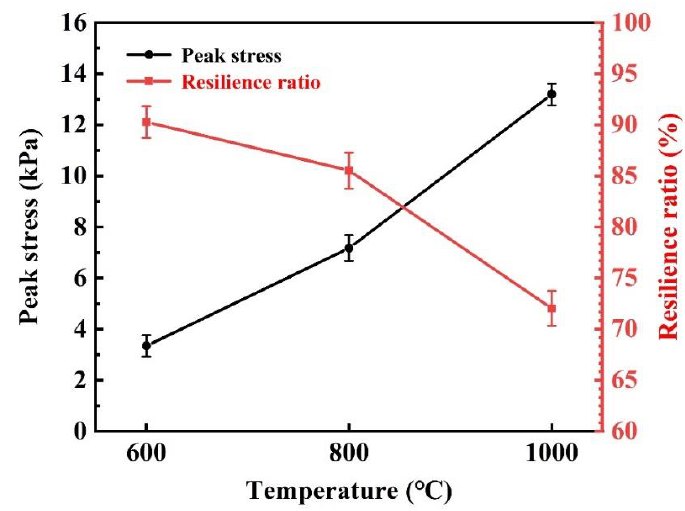
Figure 13. Peak stress and resilience ratio of SiO 2 fibrous porous materials after compression for 5 cycles under 30% stress at different heat treatment temperatures.